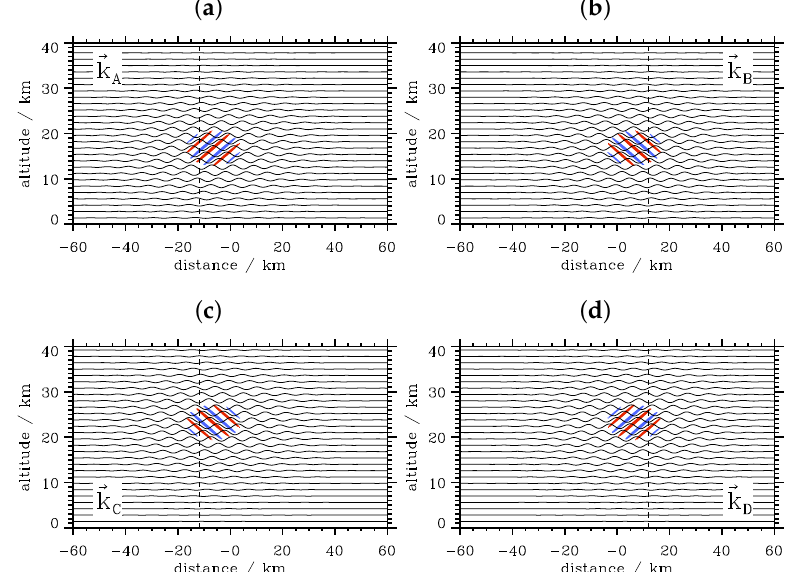
Figure 5. Spatial snapshots of the vertical displacements ξ ( x , z , t ) of horizontally- and vertically-propagating wave packets with four different wavenumber vectors (cid:126) k A ( a ), (cid:126) k B ( b ), (cid:126) k C ( c ) and (cid:126) k = 24min, respectively. The wave packets are propagating downward ( c gz < 0) in the top D ( d ) at t row and upward ( c gz > 0) in the bottom row. Red and blue contour lines refer to ± 0.95 times the wave amplitude and illustrate phase lines. The dashed black lines refer to the horizontal position where the time series shown in Figure 6 are recorded.